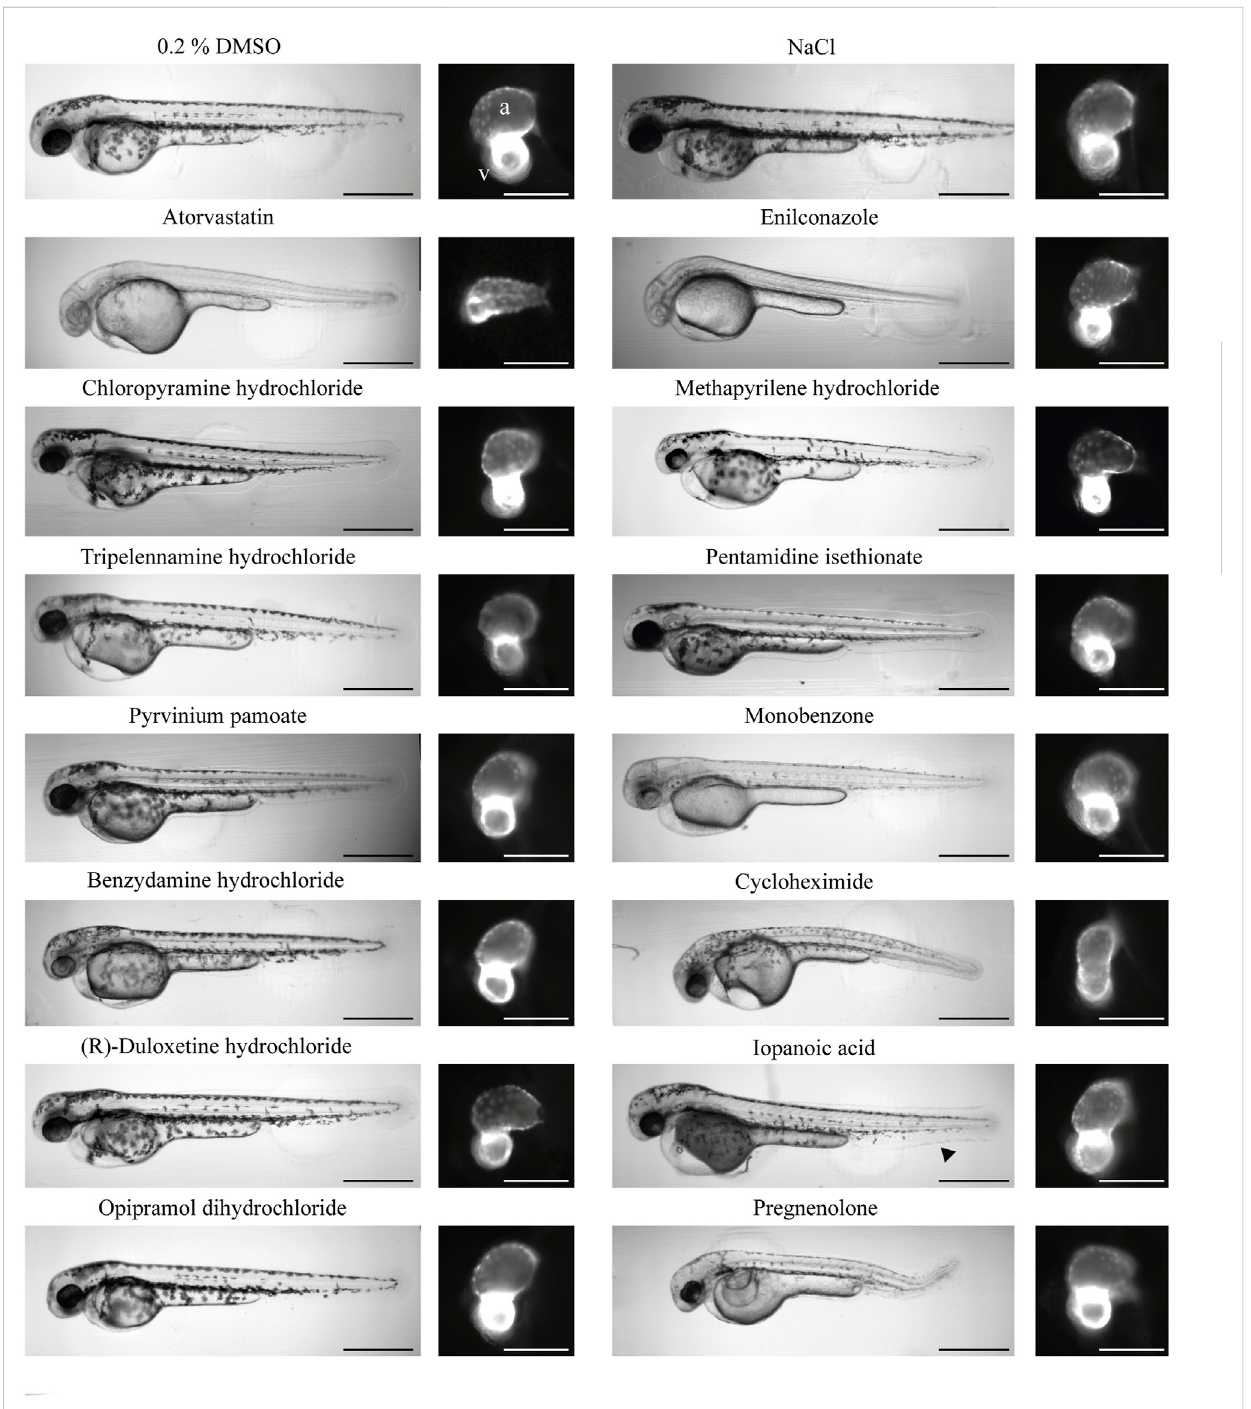
FIGURE 5 Morphology of treated zebra fi sh 2 dpf. An overview of the gross phenotypes of treated zebra fi sh 2 days post-fertilization. All compounds were dissolved in DMSO; therefore, DMSO served as the negative control. NaCl served as the salt control. The effects of atorvastatin treatment on zebra fi sh embryoswerepreviouslyestablished;thus,thisdrugwasusedasapositivecontrolforcardioactivity.Theaquatictoxiccompoundenilconazolewasused as the toxic positive control. Heart morphology was drastically affected only by enilconazole, cycloheximide, and pregnenolone. The black arrow in the image of iopanoic acid-treated zebra fi sh embryo indicates caudal fi n deformity. The scale bar indicates 500 µm in overview bright fi eld images and 150 µm in fl uorescence images. (a) Atrium; (v)